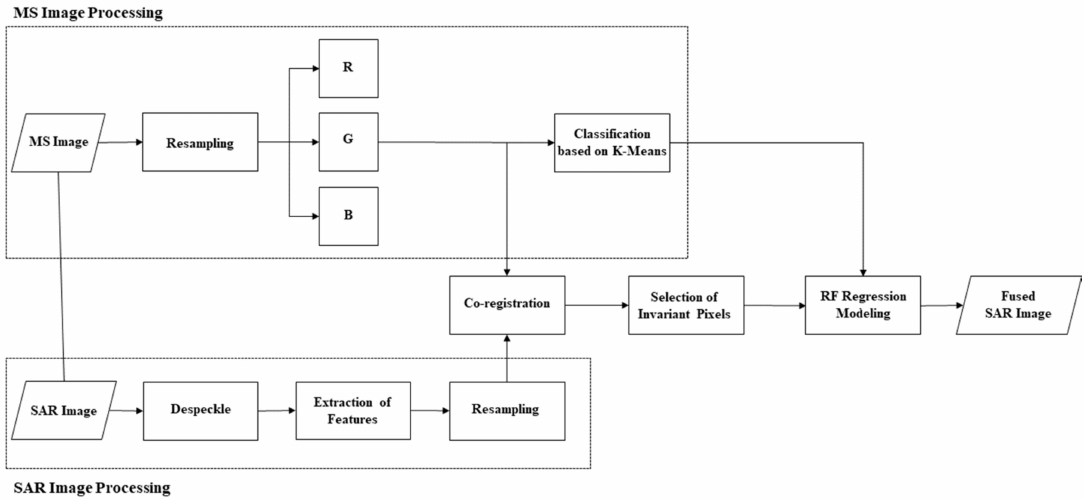
Figure 1. Fusion scheme of proposed method. MS, multispectral. SAR, synthetic aperture radar. RF, random